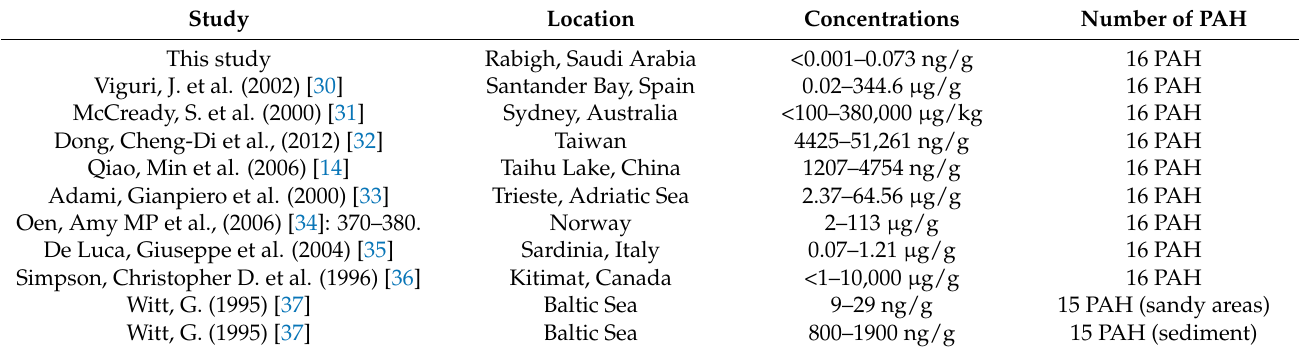
Table A3. The Concentrations of PAHs in selected